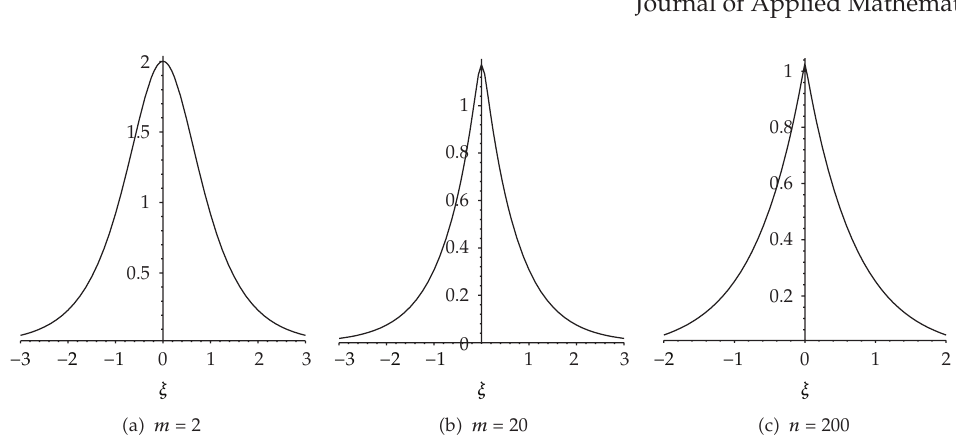
Figure 2: The solution u in (cid:2) 3.18 (cid:3) shows a shape of compacton for parameters v (cid:8) 2 , and σ (cid:8)